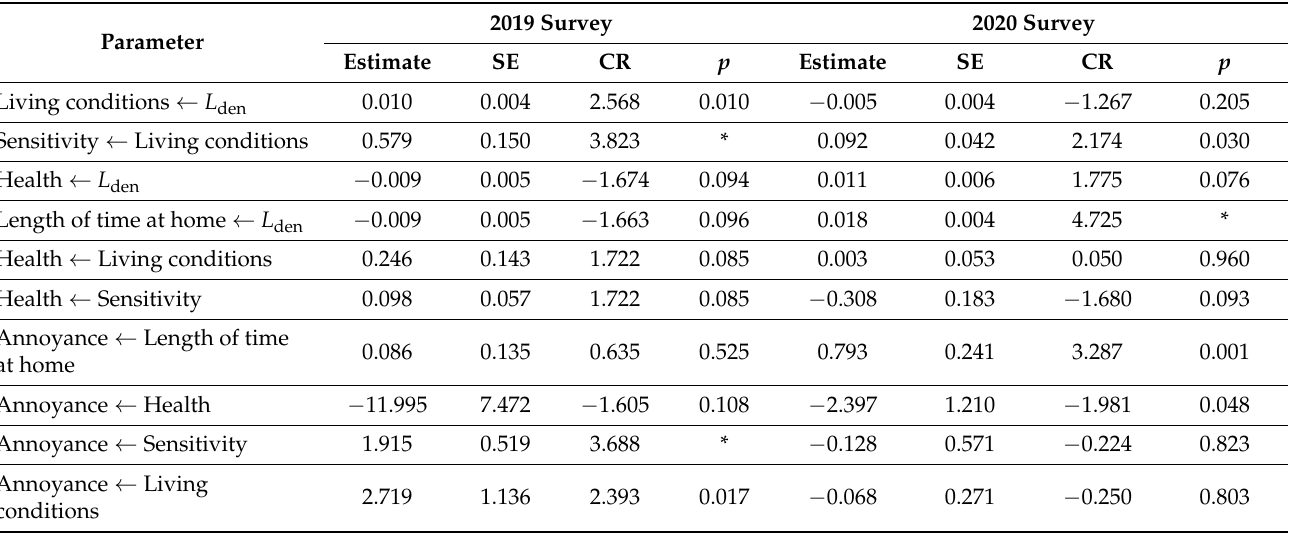
Table 12. Parameter estimates of the structural equation model for noise annoyance with length of time at